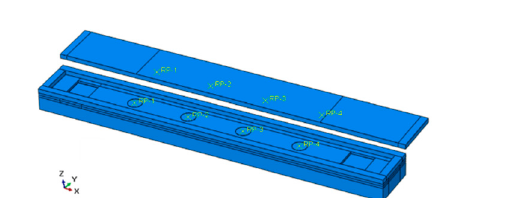
Figure 10. Linearly uniform loading. ( a ) Load and boundary conditions; ( b ) load curve. 3.3.2. Sinusoidal Loading Based on the Lab Experiment The boundary conditions and the sinusoidal load curve of the test are shown in Figure 11. The bottom of the sub-plate-2 was restrained, and the center of the sub-plate-1 was pressed. The loading zone was the same size as the loading head area in the lab experiment.